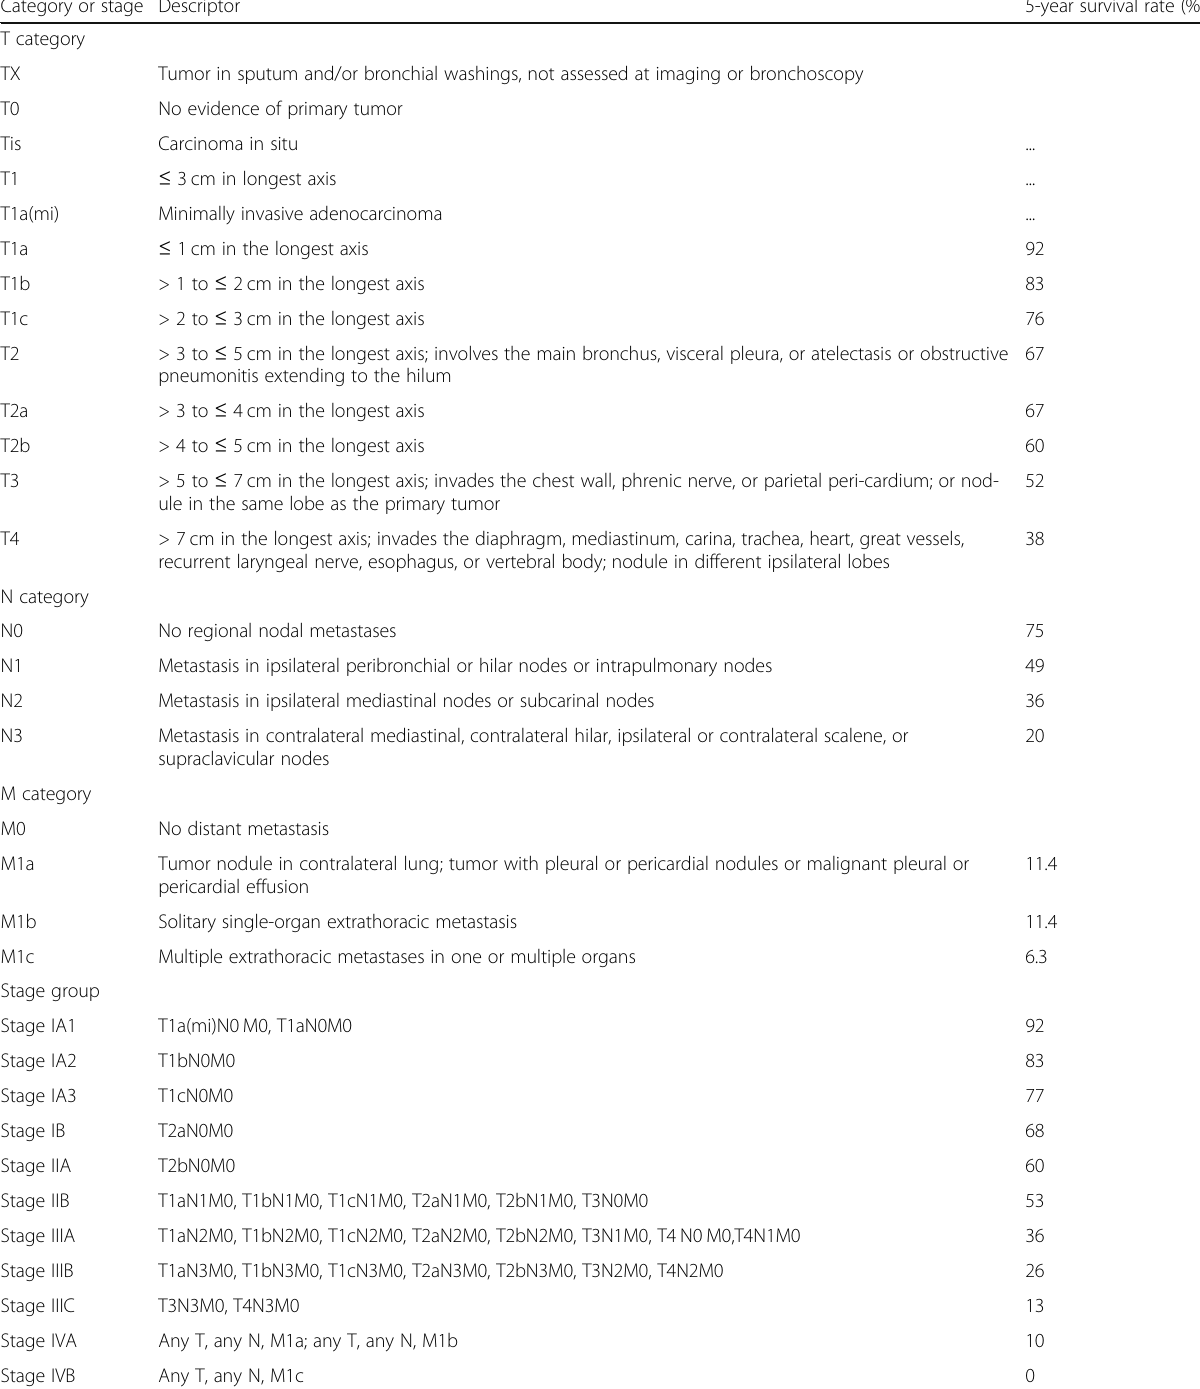
Table 1 Eighth edition of TNM staging of lung cancer [11] Category or stage